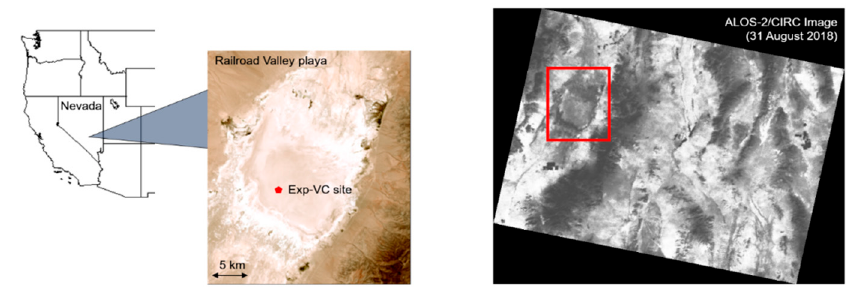
Figure 2. Location of the Exp-VC site in Railroad Valley Playa ( left ) and the ALOS-2 / CIRC image acquired over the playa on 31 August 2018 ( right ).